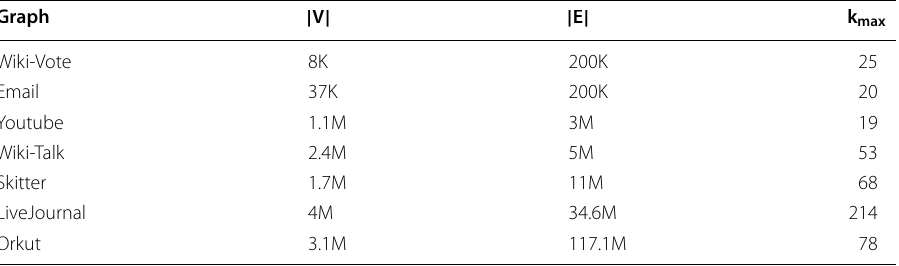
Table 2 Datasets description